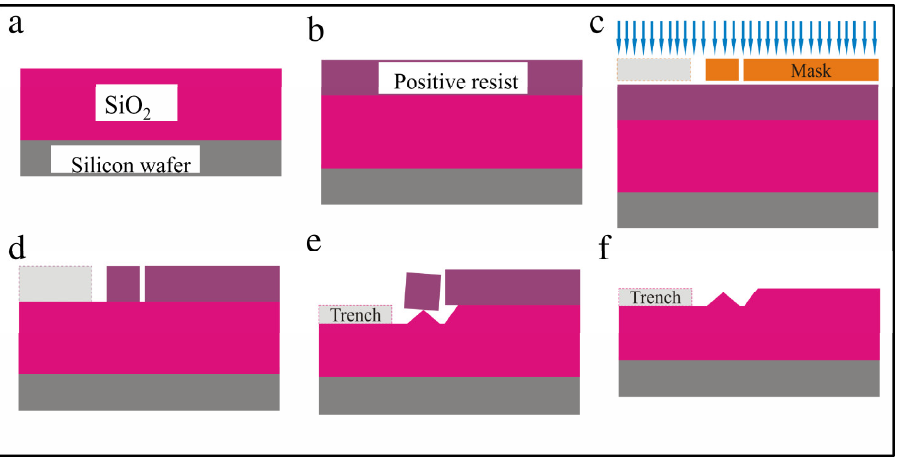
Figure 4. Schematic illustration of trench, well and tip structure formation processing steps. ( a ) Low resistivity silicon wafer with a 2-µm-thick SiO 2 layer; ( b ) resist layer spin-coated on wafer and baked for 5 min; ( c ) Mask 1 is applied during lithography exposure; ( d ) patterned wafer after developing; ( e ) isotropic etching of SiO 2 layer in 5-min hydrofluoric acid bath for trench, well, and tip formation; and ( f ) final wafer with trench, well, and tip feature after resist is removed.